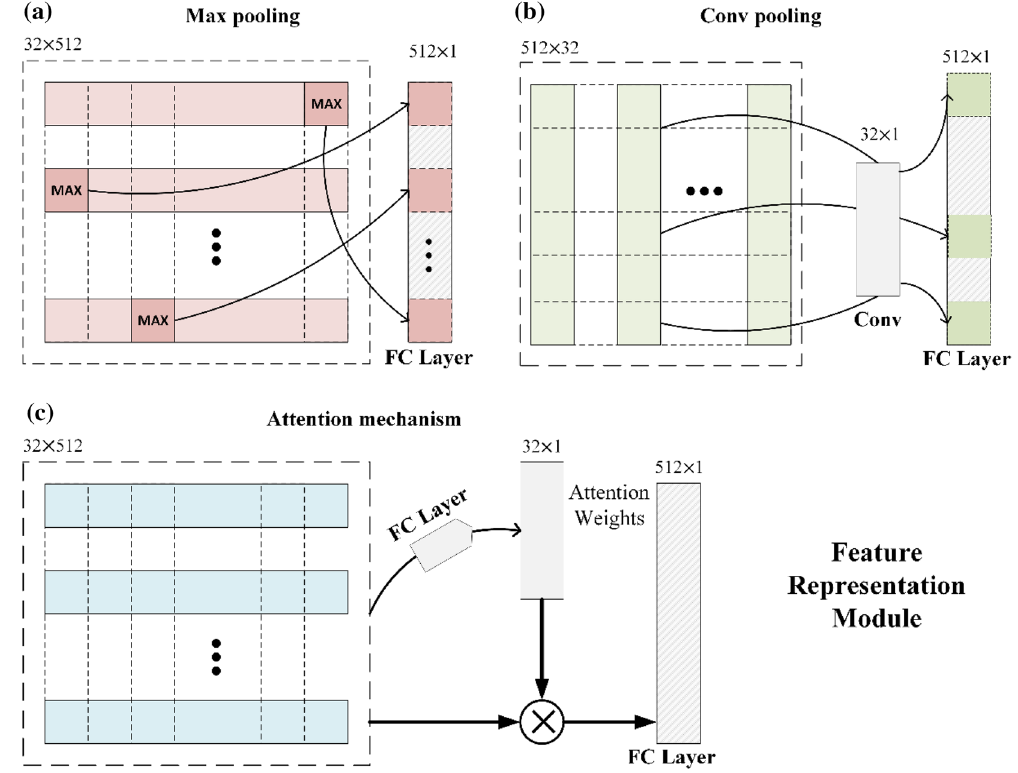
Figure 3. Feature representation module. ( a ) Structure of the max pooling method; ( b ) Structure of the convolutional pooling method; ( c ) Structure of the attention mechanism pooling